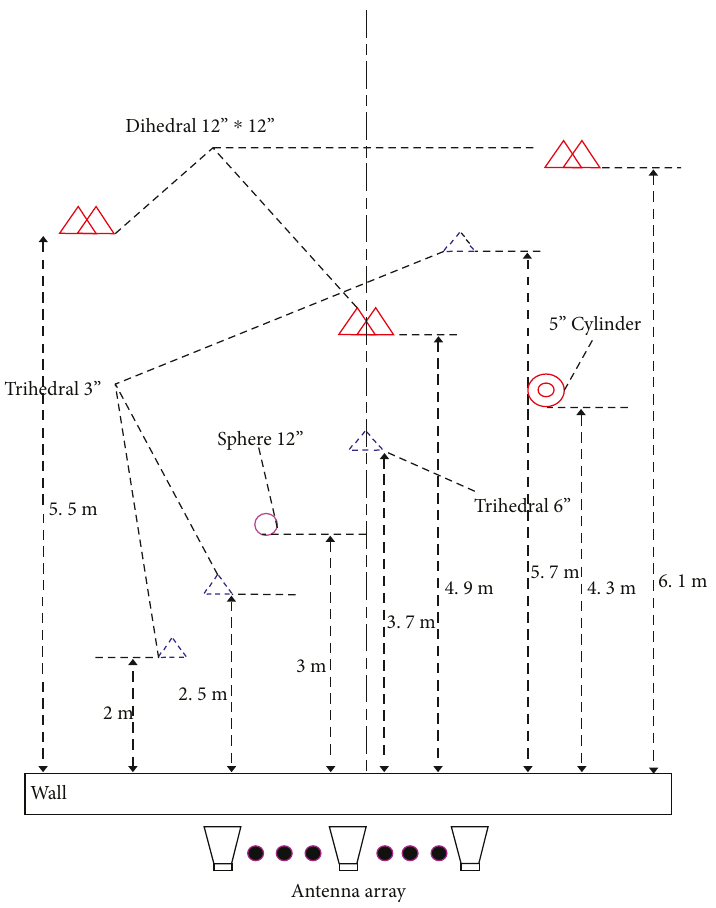
Figure 2: True positions of nine targets in the observed